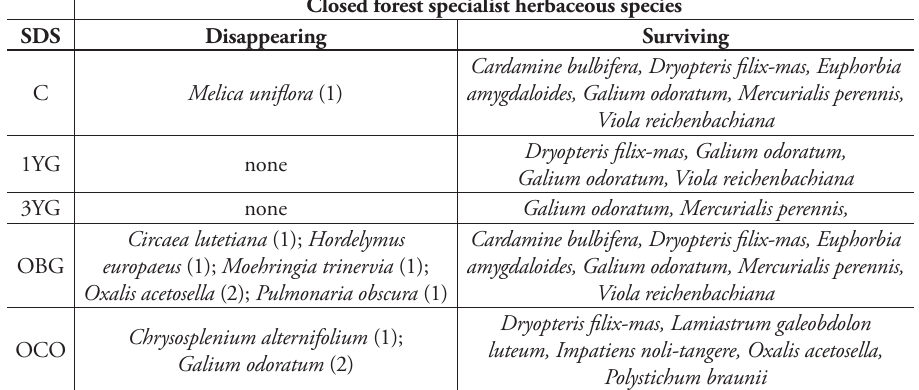
Table 7. Closed forest specialist species that disappeared from individual SDS (based on data of 25 plots each) by 2013. Numbers in brackets indicate the original number of occurrence of the species in 1996. For explanations of the stand developmental situations, see